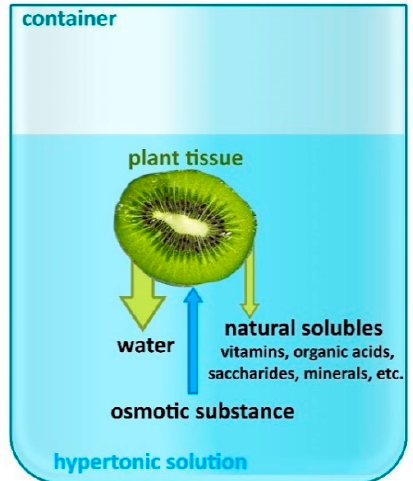
Figure 1. The mechanism of the osmotic dehydration process (e.g., kiwifruit tissue). The effectiveness of the dewatering depends on many factors: the concentration, temperature and agitation of the osmotic solution; properties of the osmoactive substance; time and conditions of the process; the type, shape, size and chemical composition